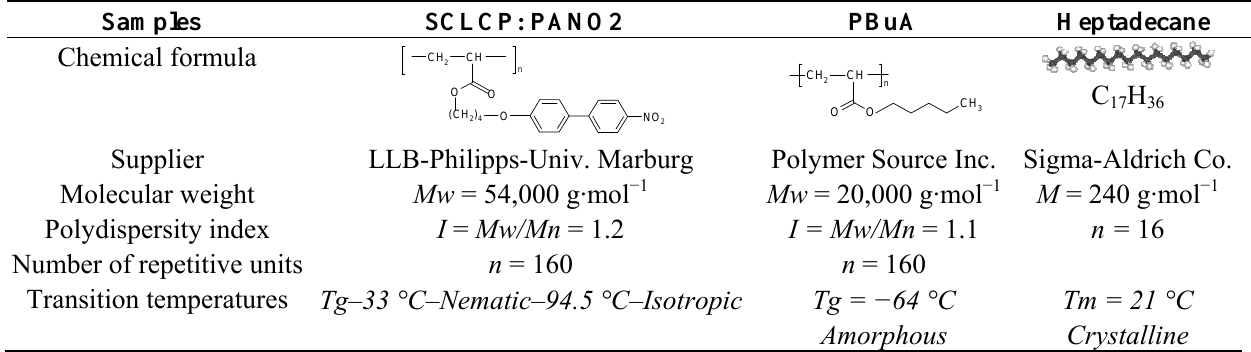
Table 1. Characteristics of the 3